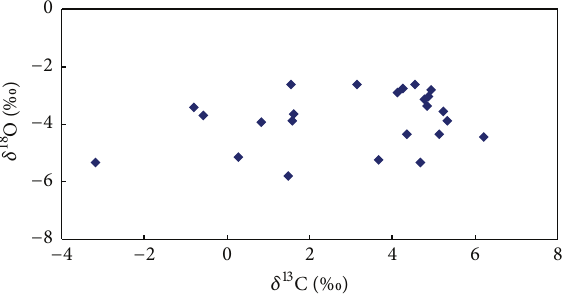
(b) Characteristics of Carbon Isotope. Carbonate rocks store